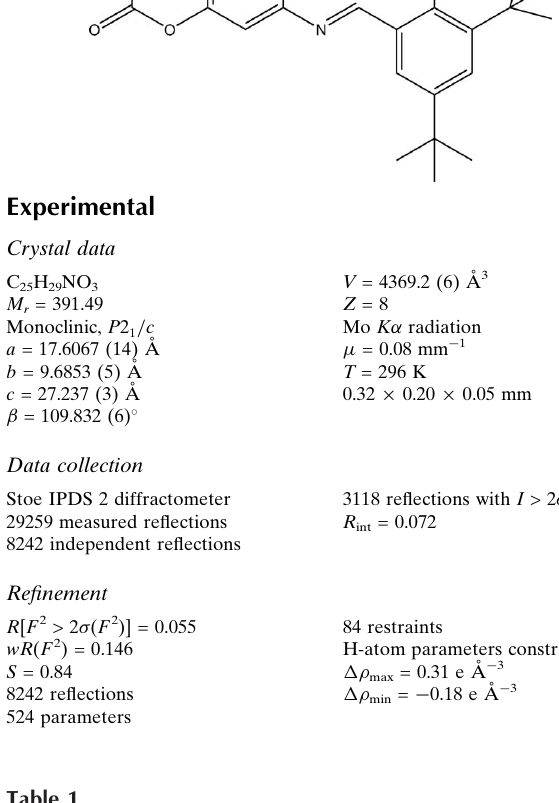
Hydrogen-bond geometry (A˚ , (cid:2) ). Cg 1 and Cg 2 are the centroids of the C26–C31 and C1–C6 rings,